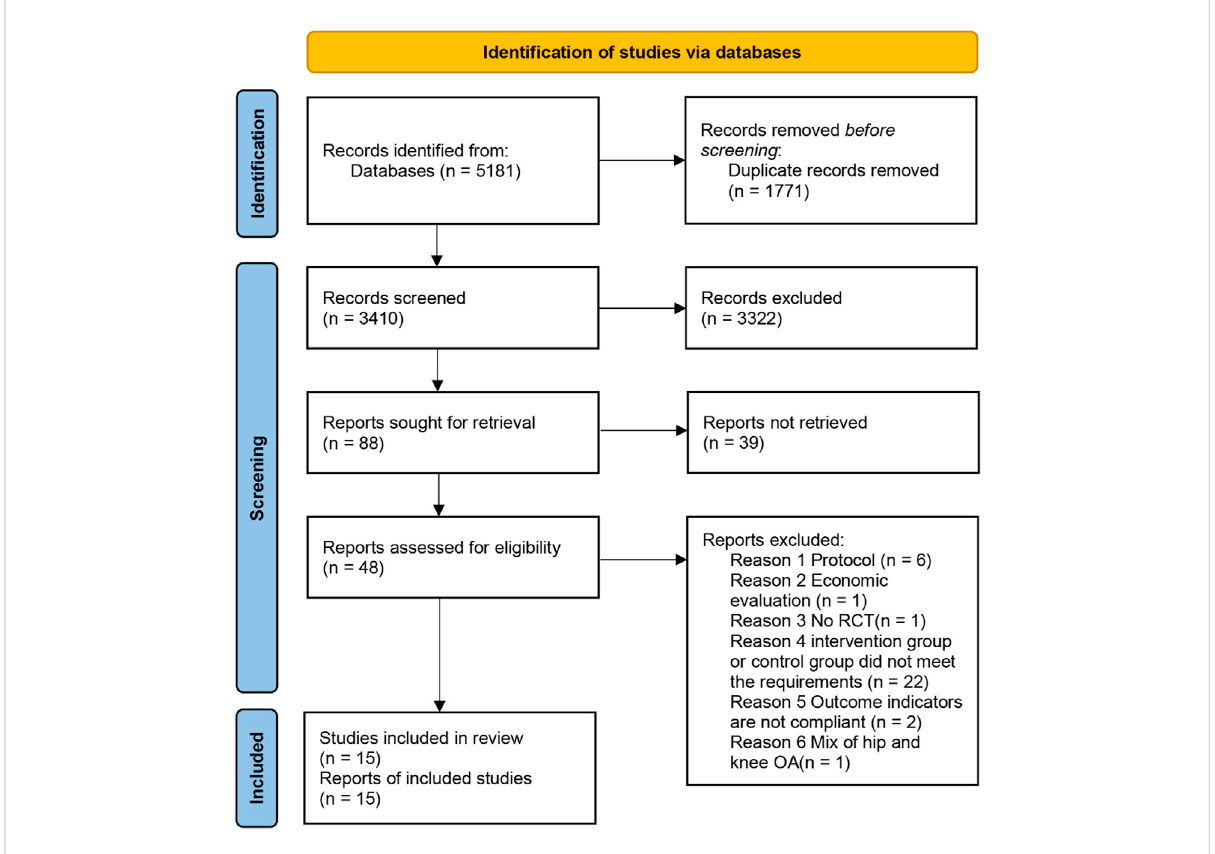
FIGURE 1 PRISMA study fl ow